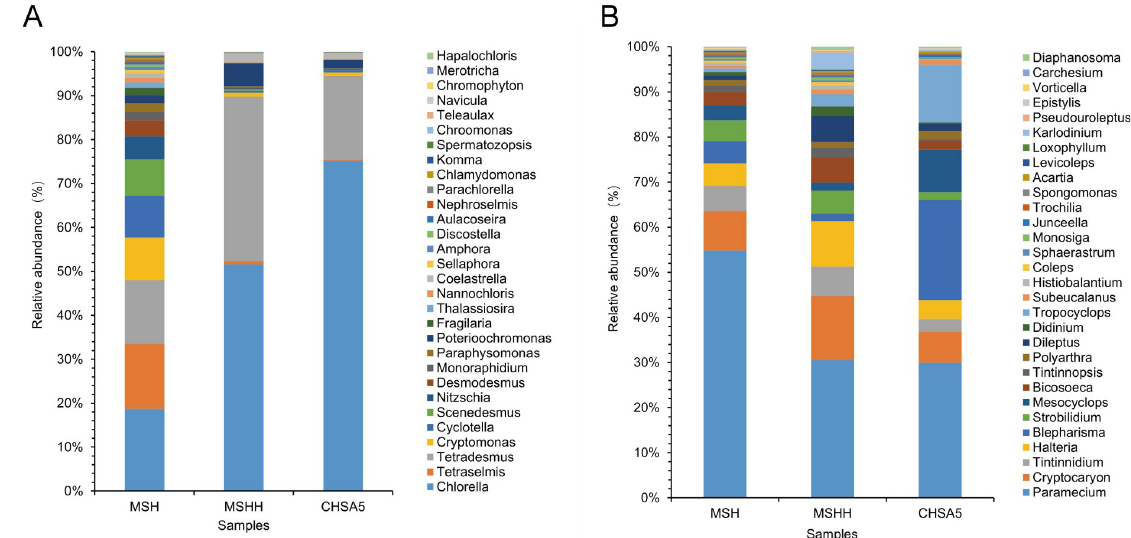
Fig 7. The relative abundance of phytoplankton (A) and zooplankton (B) at the genus level in MSH, MSHH, and CHSA5 test waters. MSH: the mosquito was living in water from the Meishe river alone. MSHH: the mosquito was living in water from the Meishe river supplemented with wild Chlorella HOC5. CHSA5: the mosquito was living in water from the Meishe river supplemented with recombinant Chlorella CHSA5.